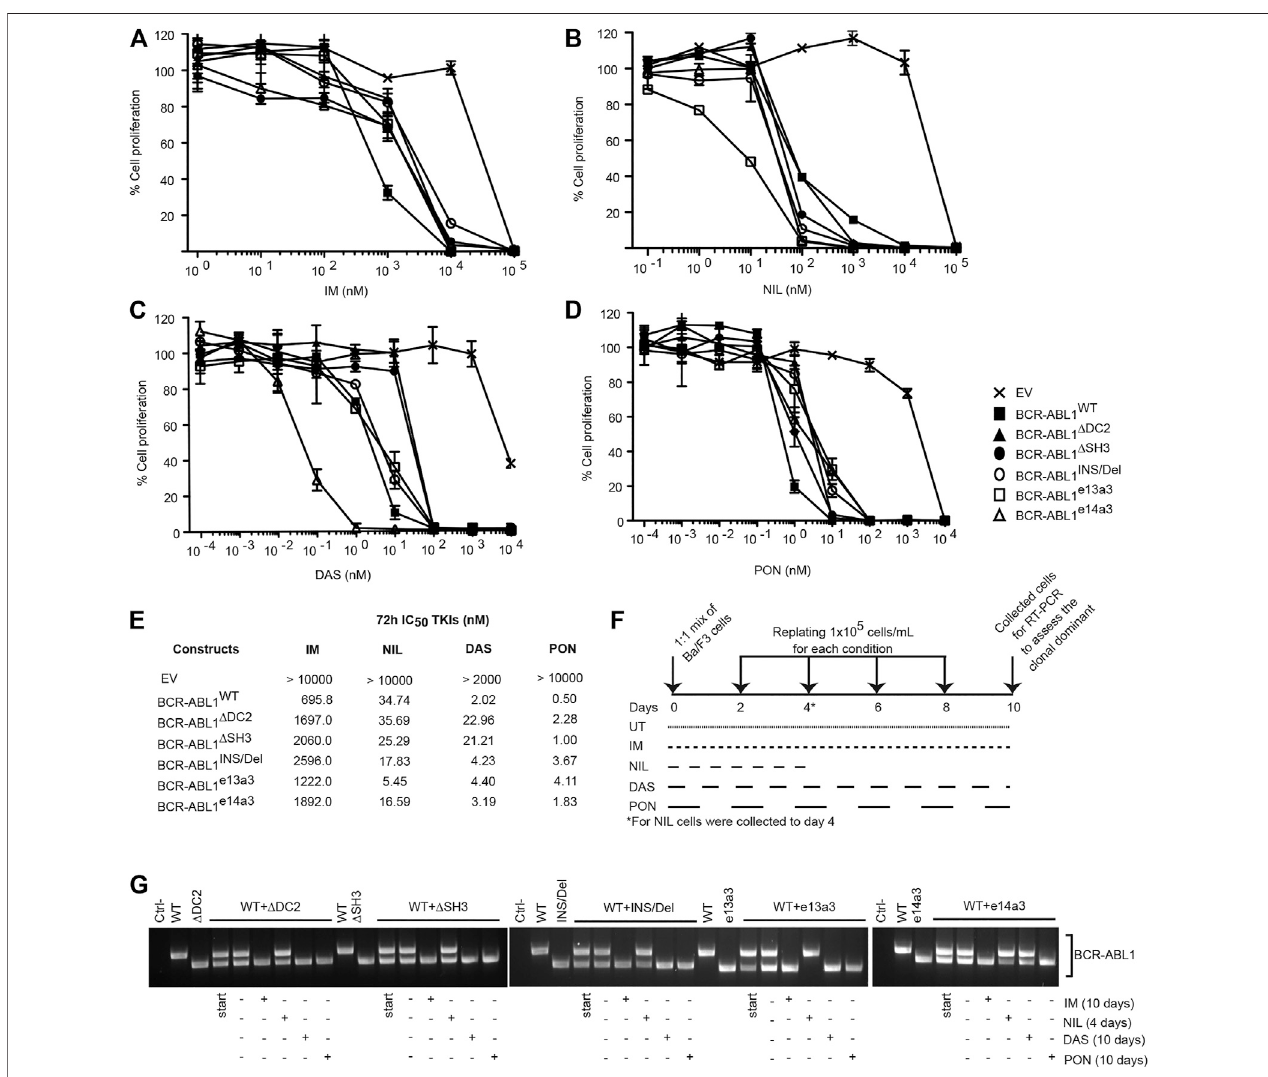
FIGURE3| Ba/F3cellstransformedbyatypical BCR-ABL1 fusiontranscriptsaremoresensitivetoNILthanIM,DASandPON. (A – D) MTSassaytode fi netheIC 50 values of Ba/F3 cells expressing the indicated BCR-ABL1 constructs after exposure to logarithmic dilutions of the speci fi ed TKIs for 72 h. Bars indicate the standard deviations obtained from three independent experiments performed in triplicates. (E) IC 50 values for each cell line were calculated using the Prism Software ® . (F) Schematic representation of the TKI treatment in the growth competition experiment reported in (G) . (G) RT-PCR on total RNA extracted from Ba/F3 cell co- cultures collected after 10 days (IM, DAS and PON) or 4 days